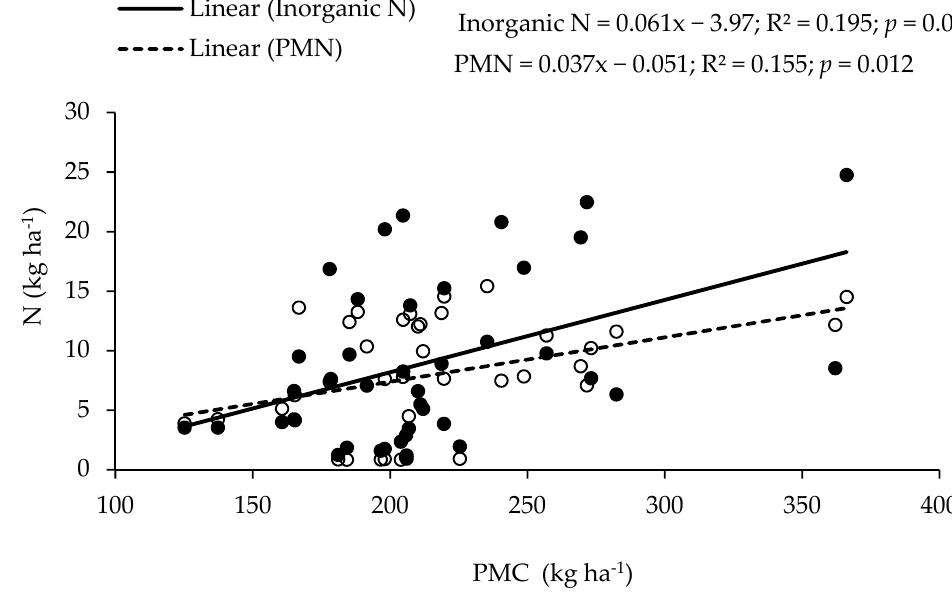
Figure 1. Simple linear regression between inorganic nitrogen (N) and potentially mineralizable N (PMN) and carbon (PMC) ( n = 40) under various cover crop treatments in 2016–2020.